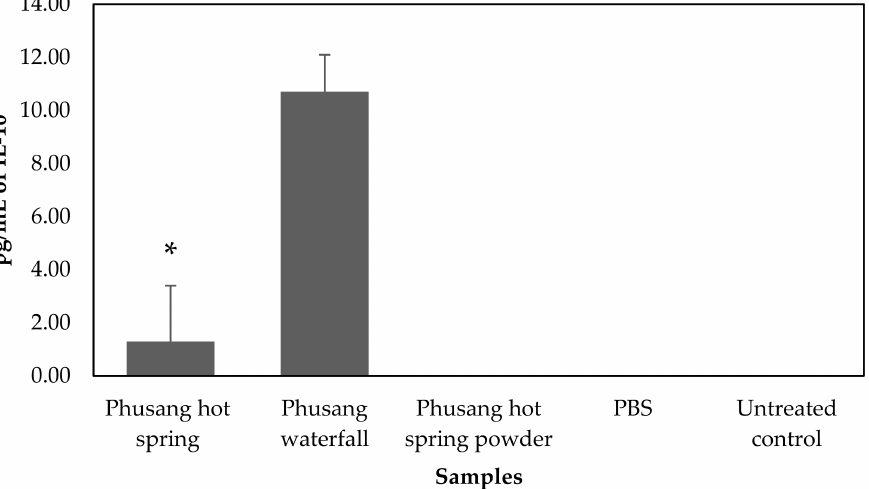
Figure 9. Levels of the IL-10 protein produced by PBMCs at 24 h, as determined using ELISA (* indicates a statistically significant difference between